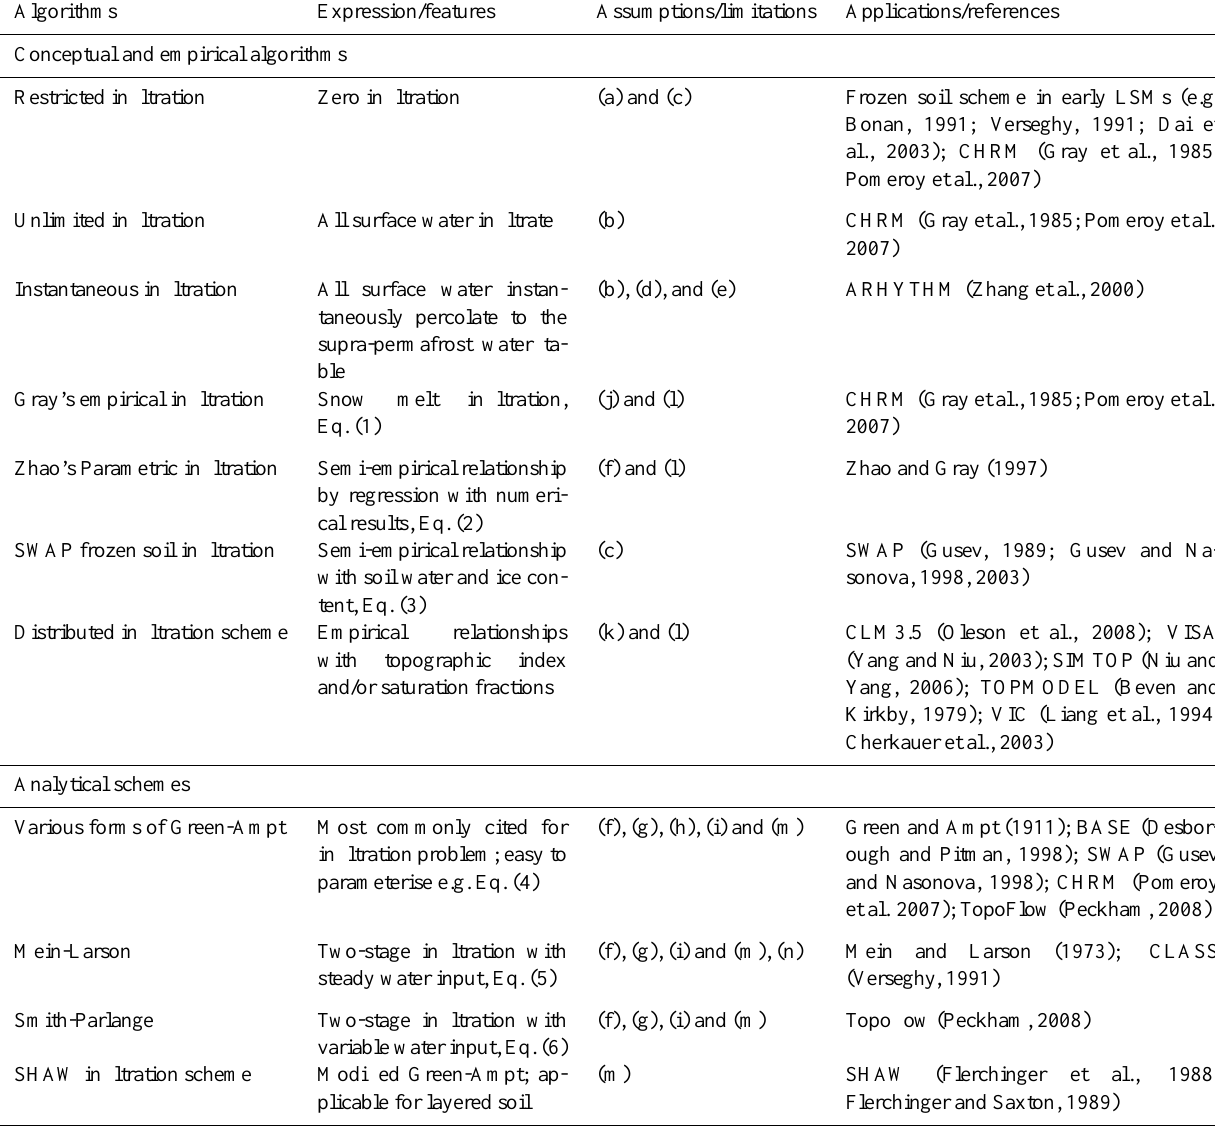
Table 2. Some conceptual, empirical, analytical and numerical infiltration algorithms and their applications and